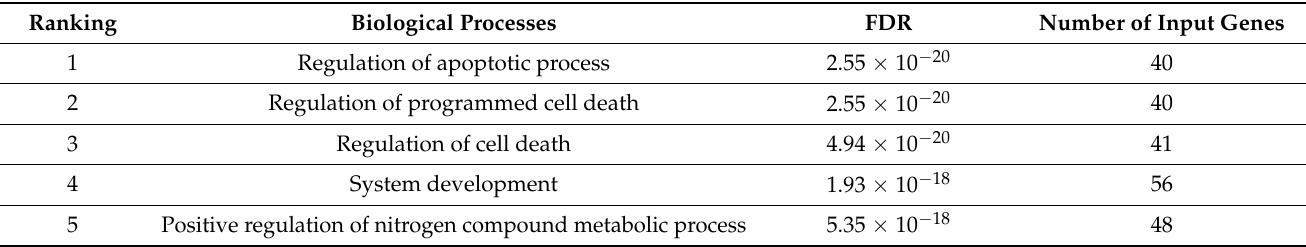
Table 2. The top five biological processes obtained from gene ontology enrichment analysis using 70 significant